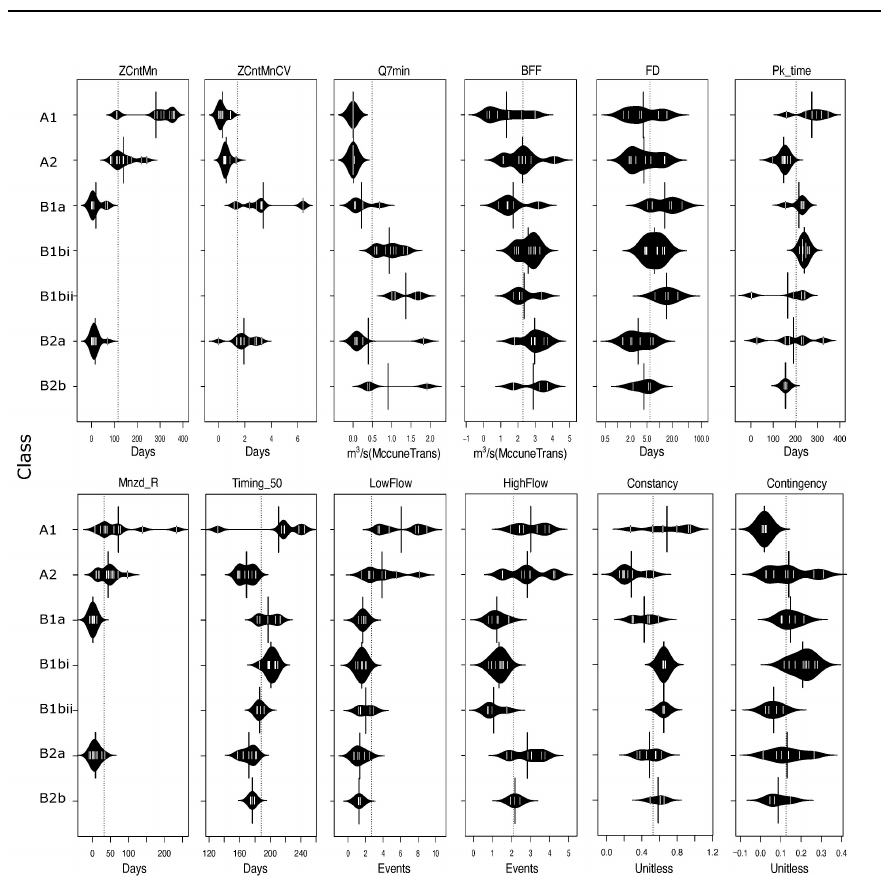
Figure 4. Density distribution plots of the metric values for each of the seven most resolved hierar- chical classes (A1 to B2b). Plots for the different metrics are presented in the same order as given in Table 2. Each panel’s dotted line represents the mean for all 287 streams. The bold intersecting line for each distribution represents the mean for each individual